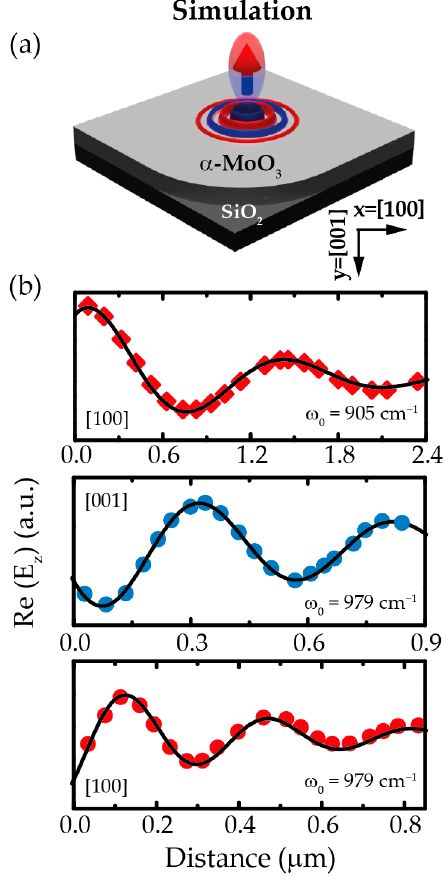
Figure 3. ( a ) Schematics of a 225-nm-thick α -MoO 3 slab on a SiO 2 substrate in which propagating PhPs are depicted by elliptical fringes (represented in red and blue). A vertically oriented electric point dipole placed on top of the structure provides concentrated electric fields that allow for launching PhPs at an incident wavelength ω 0 = 979 cm − 1 (elliptic regime). ( b ) Simulated electric field profiles (dots), Re(E z ), along the [100] and [001] crystal directions of α -MoO 3 for an incident frequency ω 0 = 905 cm − 1 (hyperbolic regime) and ω 0 = 979 cm − 1 (elliptic regime). The fit to the simulated profiles are depicted with a black solid line.